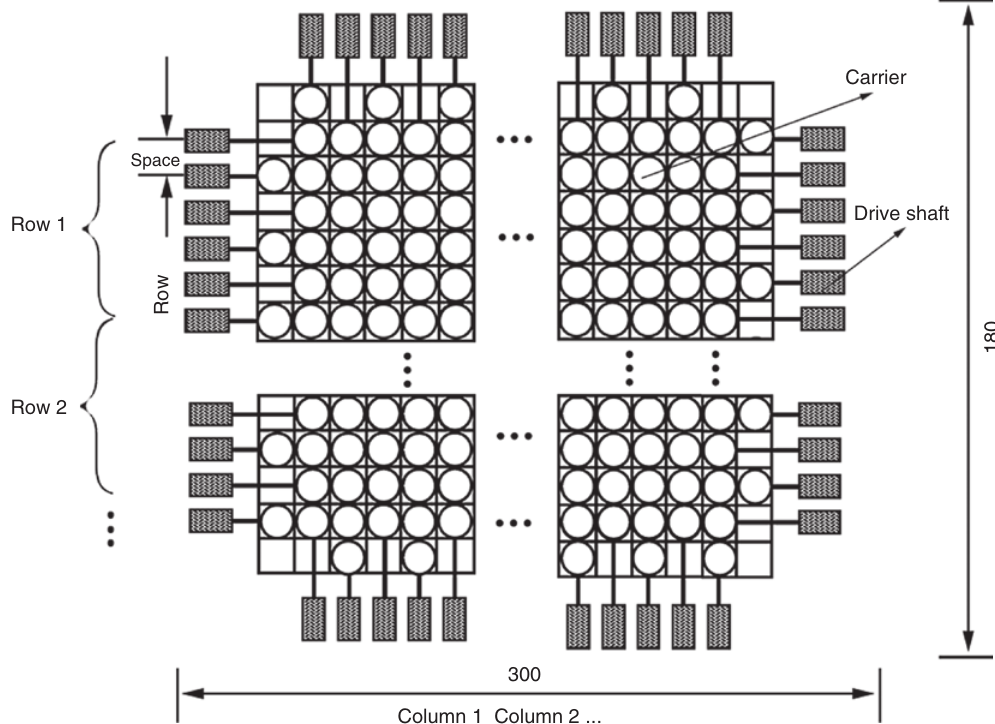
Figure 5: The mechanical structure of a regular braiding machine.